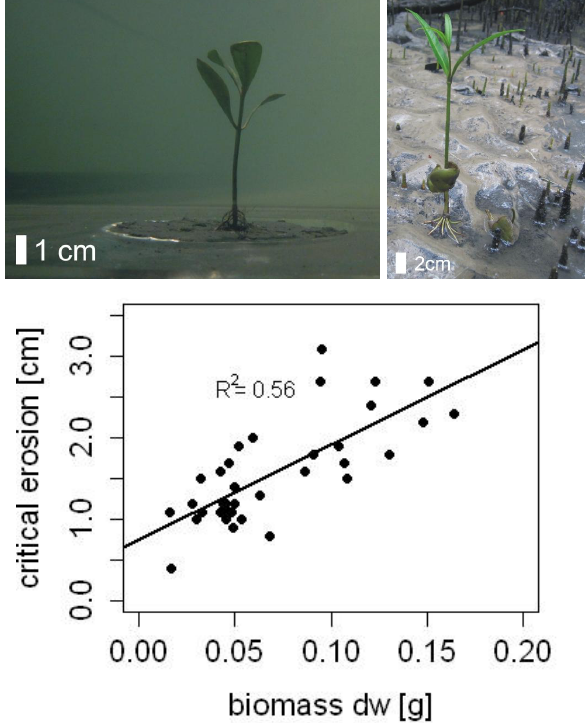
Fig. 2. Results of wave flume experiments on critical erosion depth for Sonneratia alba seedlings (left photo: S. alba in the flume) and photo of Avicennia sp. seedling showing exposed roots due to local erosion (right). Critical erosion depth ( E crit ) was linearly correlated with dry biomass of the seedlings ( B dw ) ; [ E crit = 11.678 · B dw +